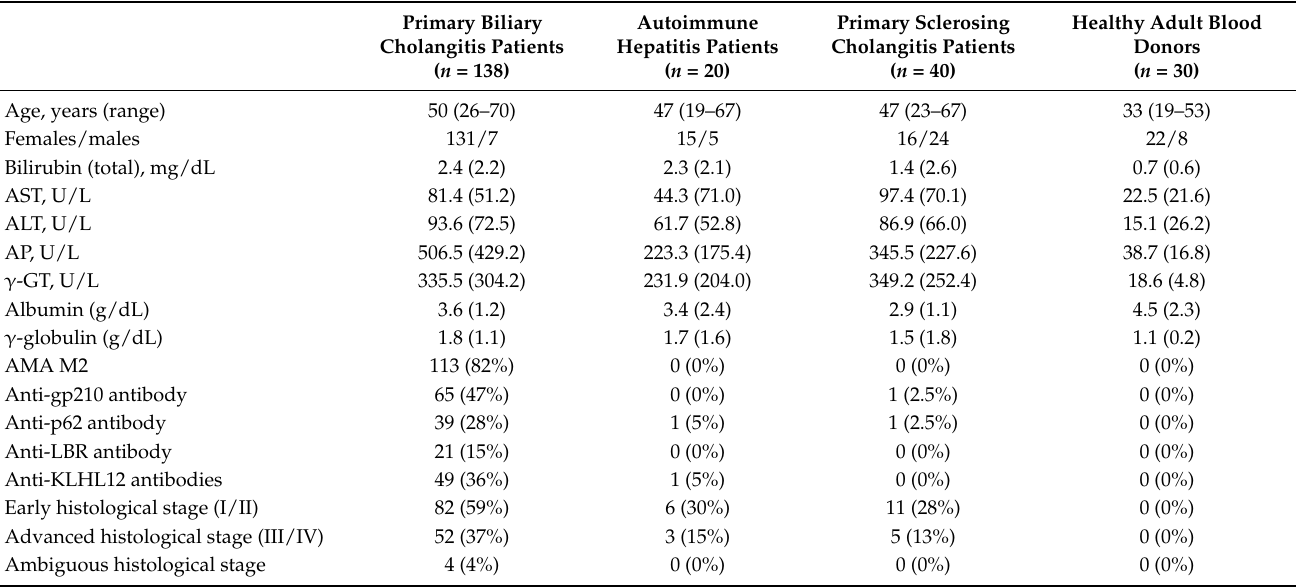
Table 1. Demographic, biochemical, immunological, and histological characteristics of PBC patients and control